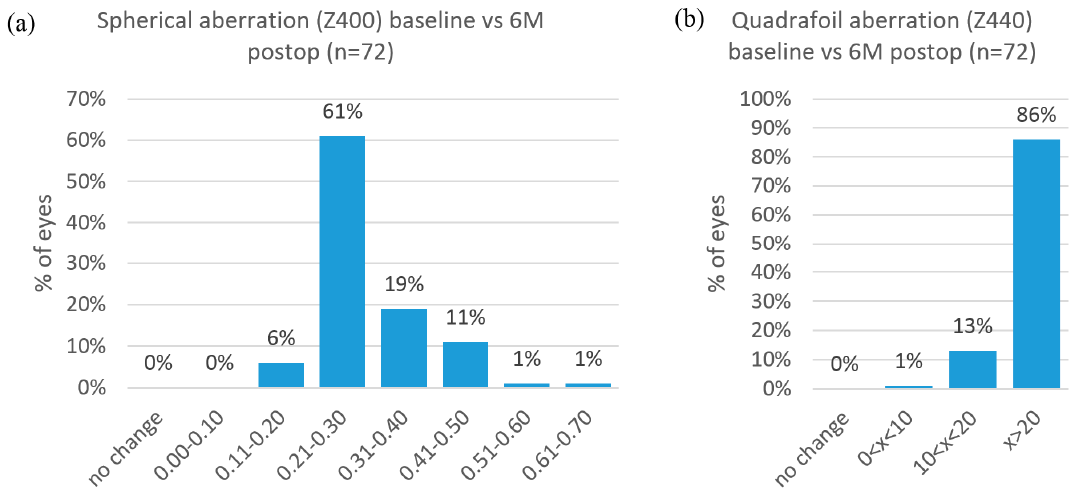
Figure 5. Surgically induced spherical ( a ) and quadrafoil ( b ) aberrations in micrometers, compared preoperatively (baseline) to postoperatively (postop). The treatment induced 0.21 to 0.40 microns of spherical aberration (Z400) and more than 20 microns of quadrafoil aberration (Z440) in most eyes.